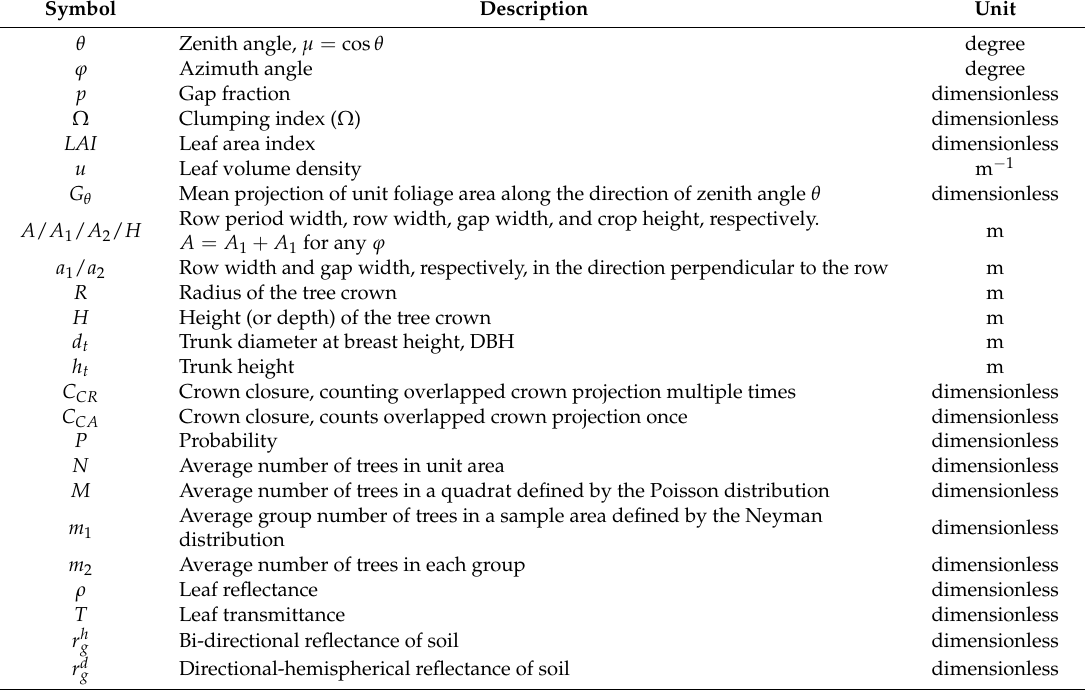
Table 1. List of symbols used in the clumping index ( Ω )